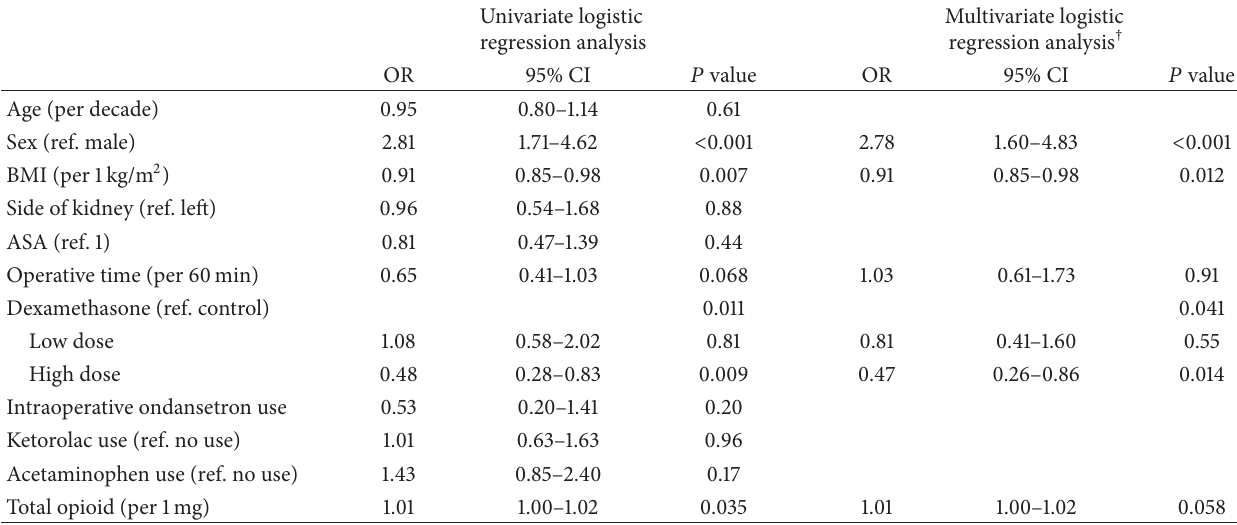
Table 2: Univariate and multivariate analyses of factors associated with postoperative nausea and vomiting.